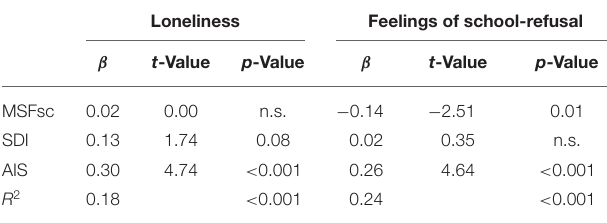
TABLE 3 | Results of hierarchical multiple regression analysis. Loneliness Feelings of